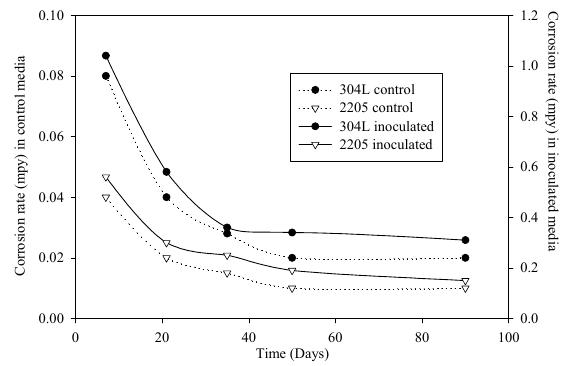
Figure 5. Corrosion rate of stainless steels subjected to immersion tests with replenishment of media.